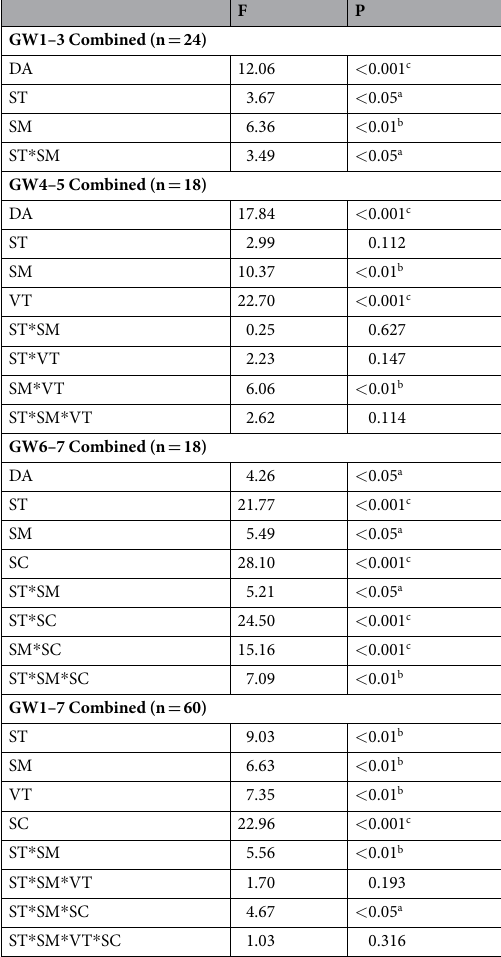
Table 2. Tests of significance of date (DA), soil temperature (ST), soil moisture (SM), vegetation types (VT), snow coverage (SC) and their interactions on the tundra ER using multivariate ANOVA (F and P values). Note: Superscripts a, b and c indicate significant effects at P < 0.05, 0.01 and 0.001,